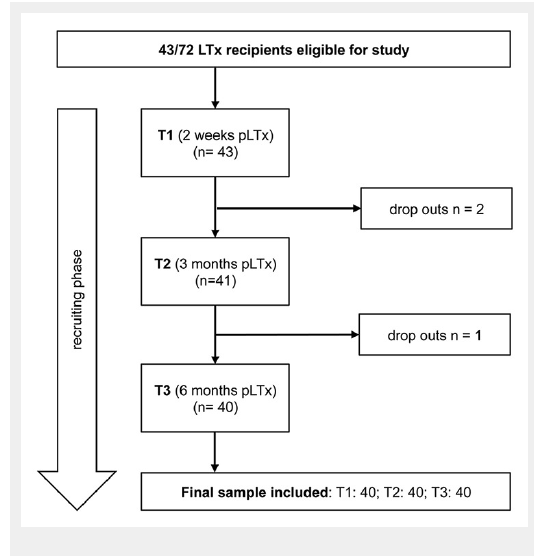
Patient recruitment. LTx = lung transplantation; pLTx = post lung transplantation; T1–T3 = three measurement